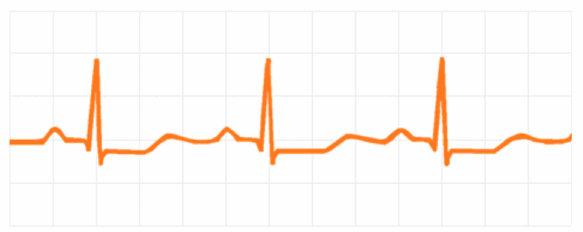
Figure 2. Drawing of an ECG showing the main changes during hypokalemia: Extension of QT interval, T wave flattening with ST-T depression, and U